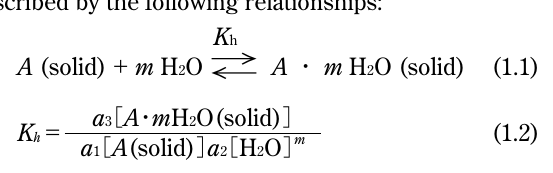
Fig. 1 Hypothetical energy diagram of an enantiotropic system ( T I and T II : melting points of Forms I and II; T t : transition temperature).